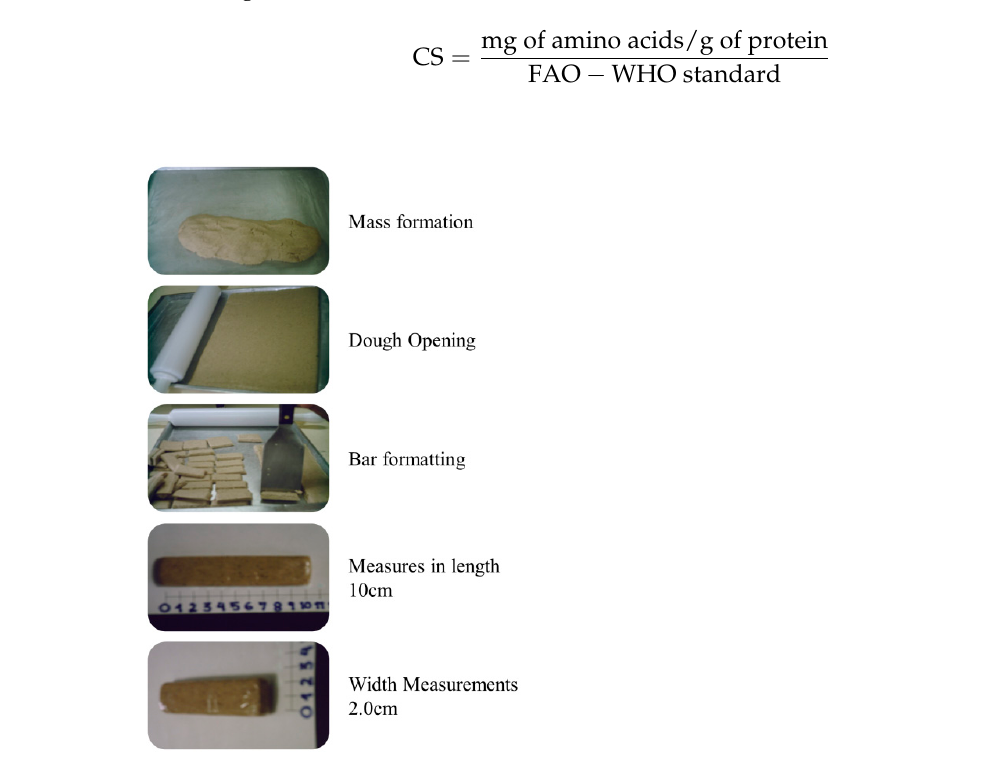
Figure 1. Product Elaboration